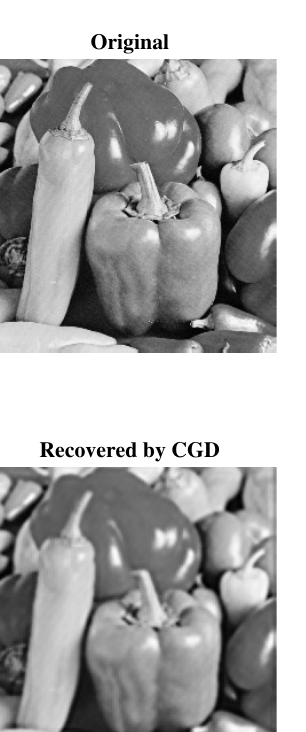
Figure 7. The original image ( top left ), the blurred image ( top right ), the restored image by CGD ( bottom left ) with SNR = 25.65, SSIM = 0.86 and by DCG ( bottom right ) with SNR = 26.37, SSIM = 0.87.